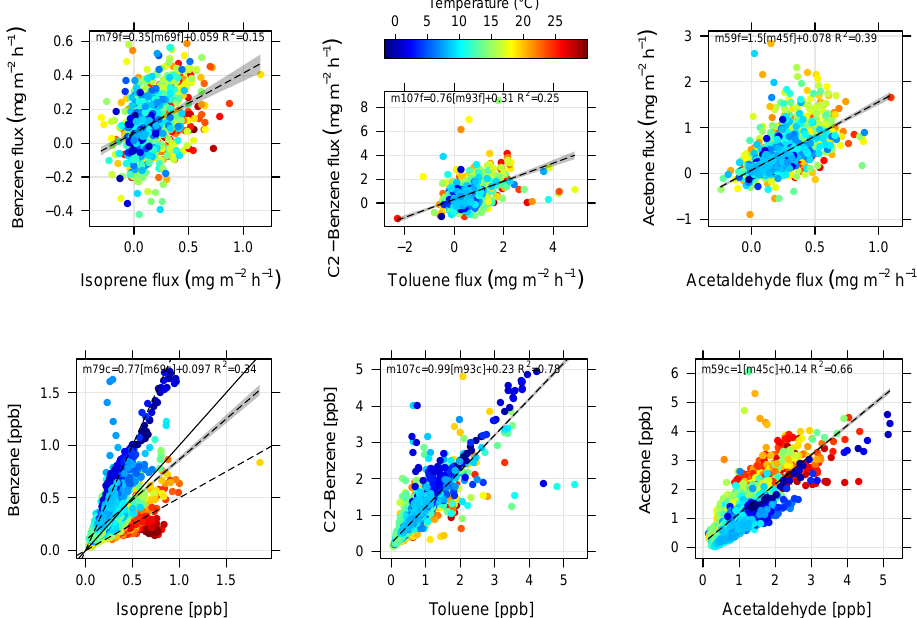
Figure 6. Selected scatter plots of representative correlations of VOC / VOC fluxes (top) and mixing ratio (bottom) with temperature as a third variable showing an example of bimodal, strong linear and medium linear correlations as commonly seen in the mixing ratio correlations with R 2 values, 1:1 line, 1:2 and 2:1 lines for the bimodal example in the bottom left